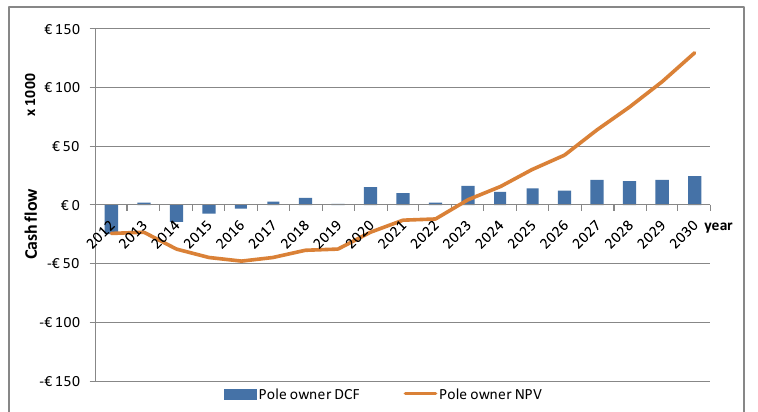
Figure 13. Evolution of the NPV for the charging pole owner (scen. D)